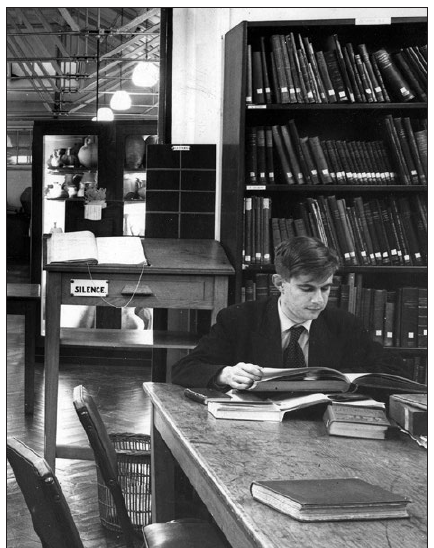
Figure 5: Eric Uphill in the UCL Department of Egyptology, 1960 (Photo: UCL Petrie Museum of Egyptian